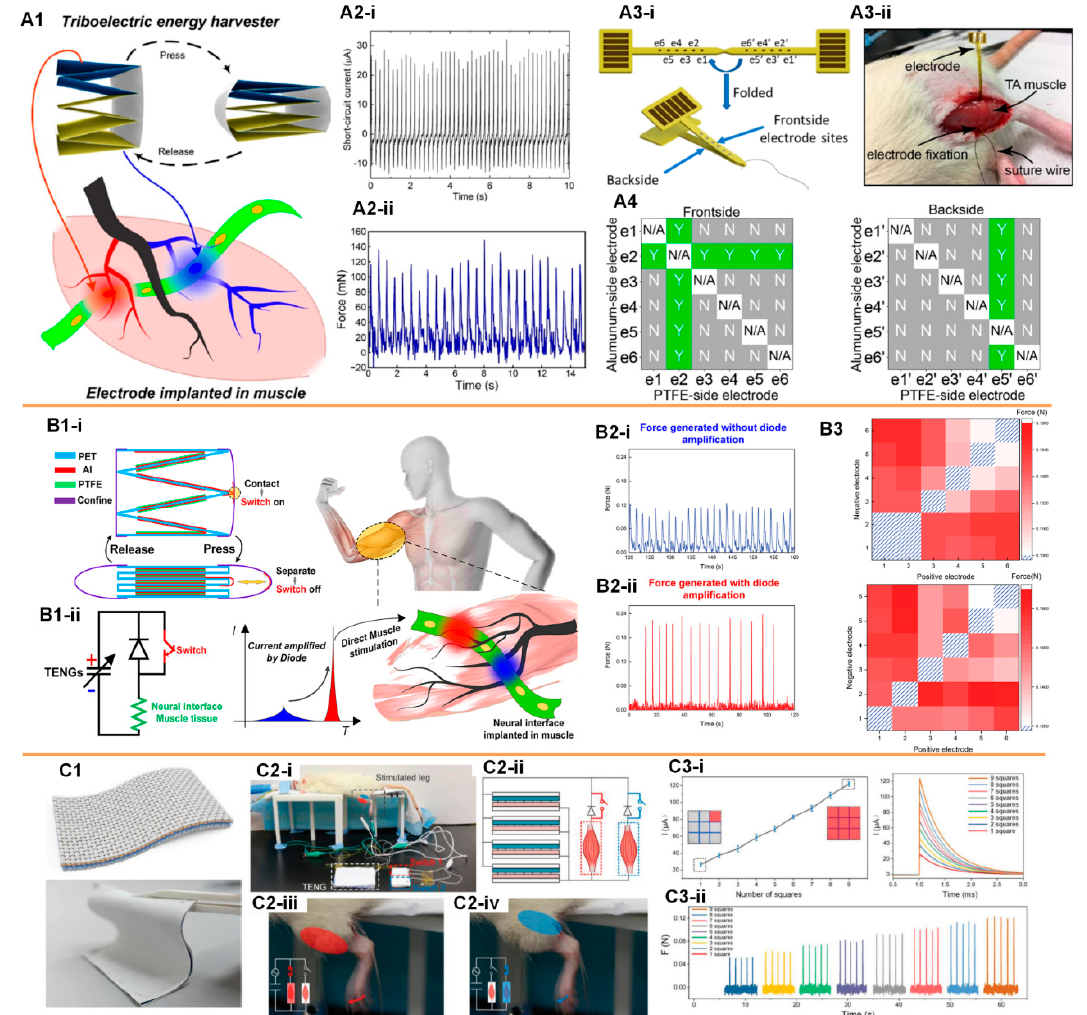
Figure 2. TENG-based direct muscle stimulations. ( A ) The muscle stimulation by a stack-layer TENG device connected with an intramuscular neural probe: ( A1 ) Schematics of the self-powered muscle stimulations; ( A2 ) The current output of the TENG device ( i ) and the generated force by muscle stimulations ( ii ); ( A3 ) The structure ( i ) and the implantation ( ii ) of the intramuscular neural probe used for muscle stimulations; ( A4 ) The feasibility of muscle stimulations for different electrode pads combinations. Reproduced with permission from [19]. Copyright 2019 American Chemical Society; ( B ) An improved muscle stimulation method using a switching operation to achieve higher efficiency: ( B1 ) Schematics of the switch-involved TENG-based self-powered muscle stimulation; ( B2 ) The force of muscle stimulations without ( i ) and with ( ii ) the current amplification; ( B3 ) The force of muscle stimulations by different electrode pads combinations. Reproduced with permission from [20]. Copyright 2019 Elsevier; ( C ) According to the switching operation, a soft fabric-based thin-film TENG device can achieve selective and controllable muscle stimulation [21]: ( C1 ) The fabric-based thin-film TENG device; ( C2 ) Schematics of the selective muscle stimulation by the switch-involved operation of the fabric-based thin-film TENG device; ( C3 ) The generated force by muscle stimulations can be controlled by the pressing area of the fabric-based thin-film TENG device.